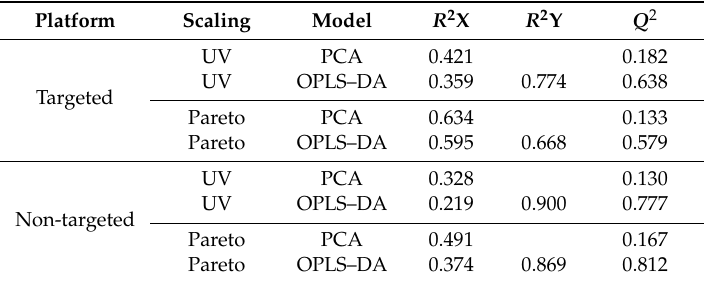
Table 1. Model validation results from multivariate statistical analysis (principal component analysis (PCA) and orthogonal partial least squares discriminant analysis (OPLS–DA)) of targeted and non-targeted metabolite profiling platforms with unit variance (UV)- and